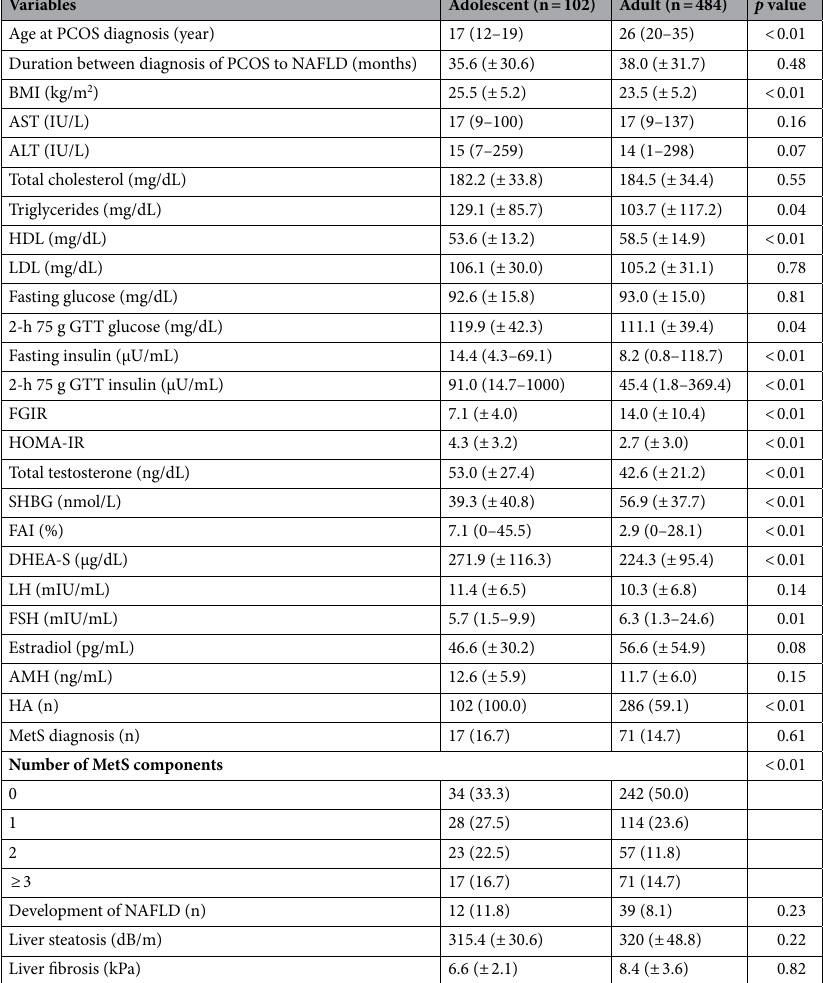
AMH anti-Müllerian hormone, AST aspartate transaminase, BMI body mass index, DHEA-S dehydroepiandrosterone sulfate, FGIR fasting glucose insulin ratio, FSH follicle stimulating hormone, GTT glucose tolerance test, HA hyperandrogenism, HDL high-density lipoprotein, HOMA-IR homeostasis model assessment of insulin resistance, LDL low-density lipoprotein, LH luteinizing hormone, MetS metabolic syndrome, PCOS polycystic ovary syndrome, SHBG sex hormone binding